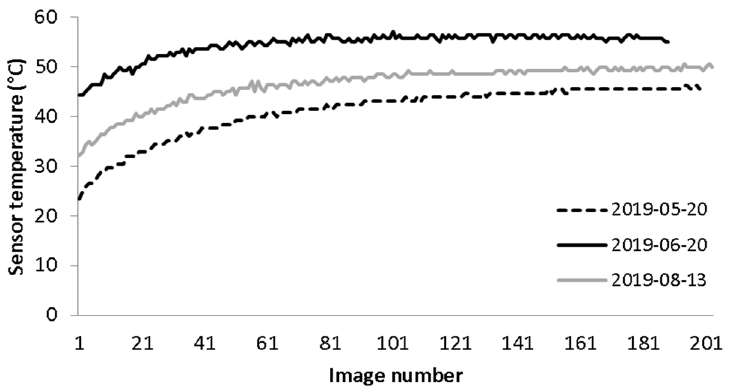
Figure 12. Sequoia sensor temperature for the green band during the flights in 2019 (Table 2).